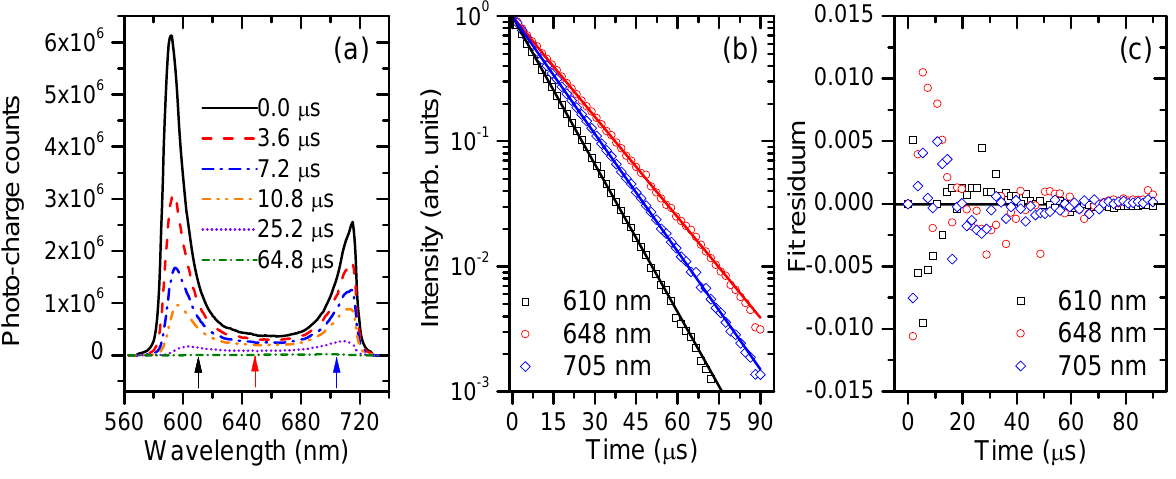
ring-down signals for the wavelengths that are indicated by arrows situated below the transmission curves on panel (a). The decay constants are τ = 16.097 ± 0.075 μ s, τ = 13.882 ± 0.046 μ s, respectively, from the shortest to the τ 0 0 longest of wavelengths. (c) Fit residua of the signals from panel